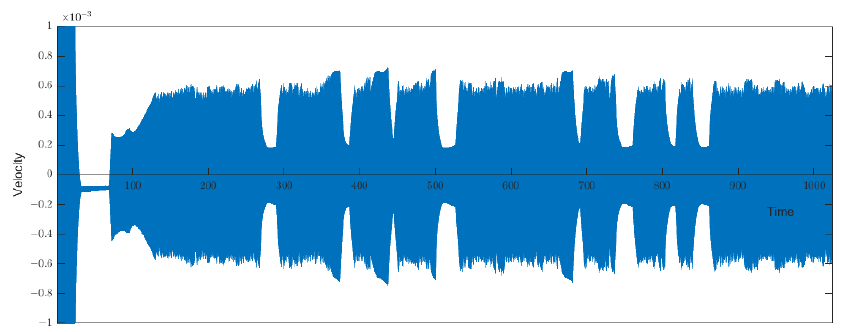
Figure 1. Example of velocity under the assumption of the orthogonality condition b = c